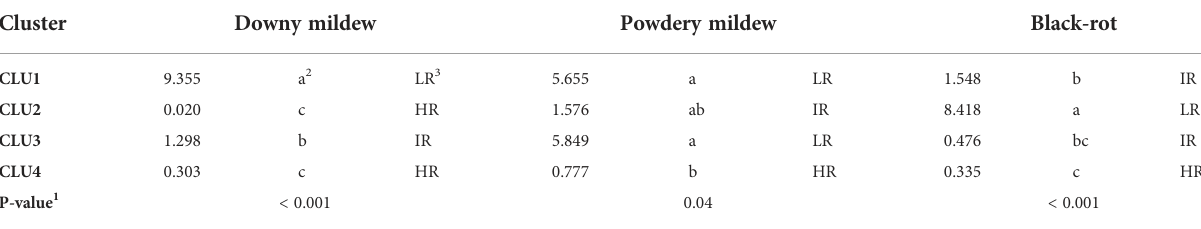
TABLE 2 Average values of AUDPC (area under the disease progress curve) for each disease on leaves and bunches for the four clusters of grapevine varieties shown in Figure 5 . Cluster